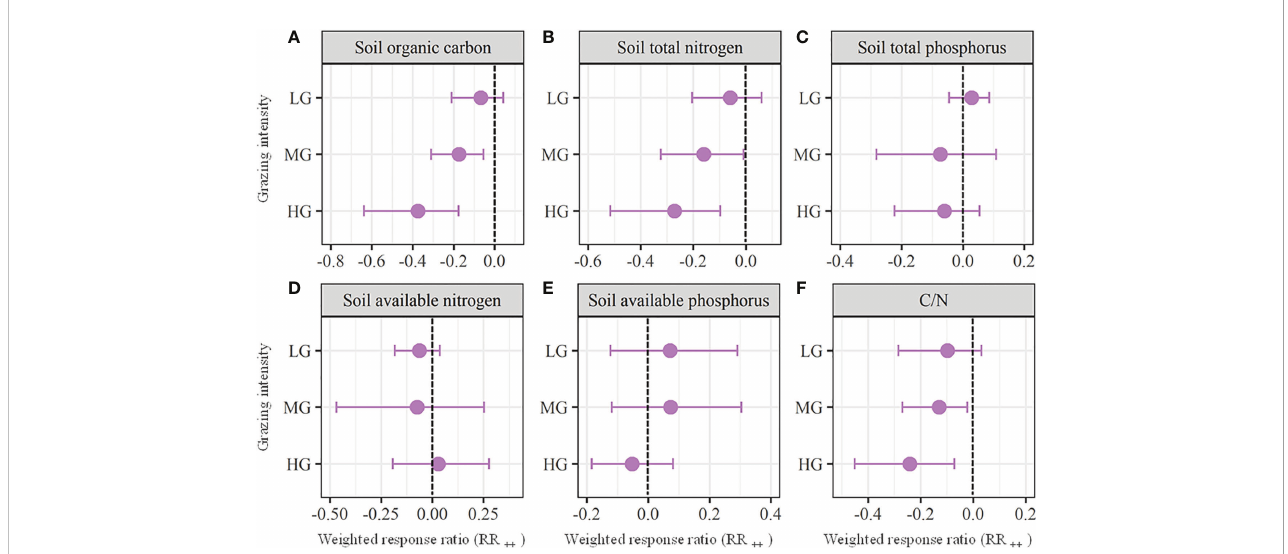
FIGURE 4 Weighted response ratios (RR ++ ) and their 95% con fi dence intervals (CI) for soil nutrients including soil organic carbon (A) , total nitrogen (B) , total phosphorus (C) , available nitrogen (D) , available phosphorus (E) , and ratio of carbon to nitrogen (F) in the lightly (LD), moderately (MD), and heavily (HG) grazing alpine grasslands. The overall effect sizes are unitless grand means from weighted meta-analyses. The dots with error bars indicate the mean effect size with the 95% CI. The observed effect sizes were considered statistically signi fi cant if the 95% CI did not include